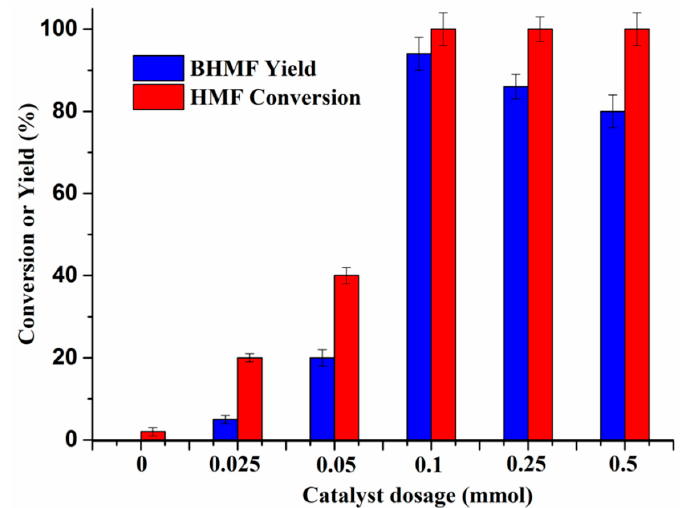
Figure 5. Influence of K 2 CO 3 dosage on synthesis of BHMF from HMF. (Reaction conditions: HMF (0.5 mmol), Ph 2 SiH 2 (1.4 mmol H − ), MTHF (2 mL), 25 °C, and 2 h; After the reaction, 3 mL methanol was added into the resulting mixture, followed by stirring under ambient conditions for 30 min.)